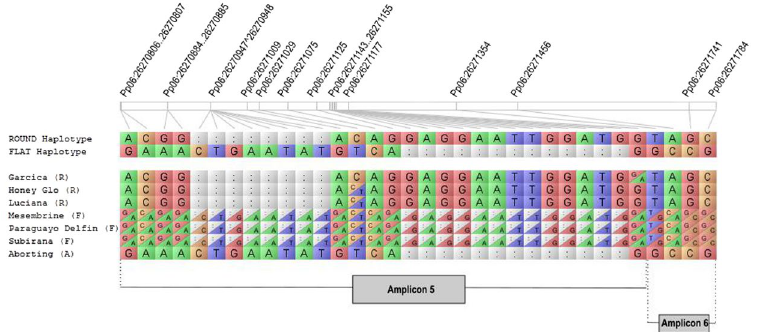
Figure 1. Round and flat associated haplotypes in round (R), flat (F) and aborting (A) peaches. Colon represents the deletion of a nucleotide. The haplotypes consist of 13 SNPs and two INDELS, in Amplicon5